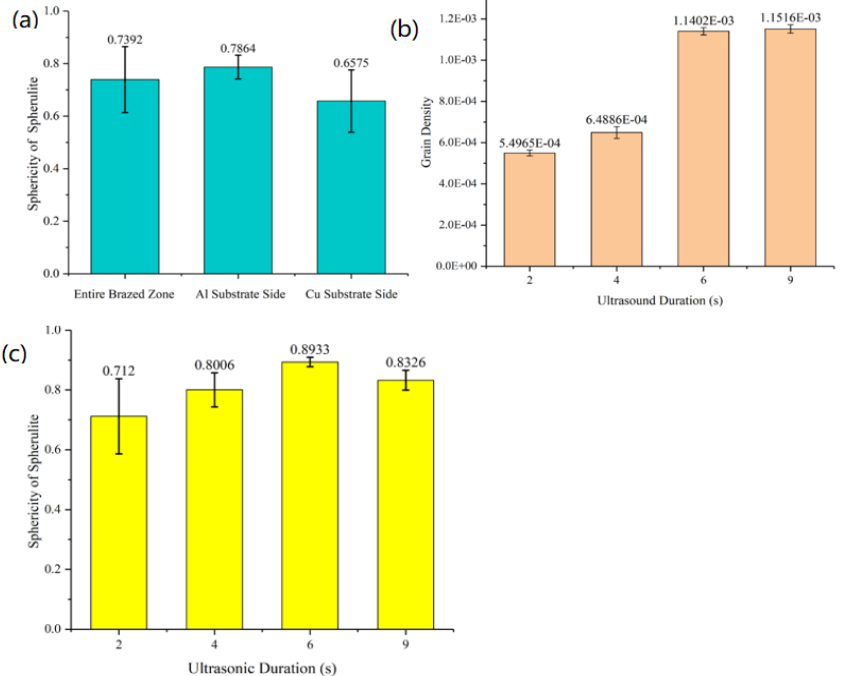
Figure 9. ( a ) spherulite sphericity of each weld seam area when ultrasonic vibration time is 2 s; ( b ) grain density under different ultrasonic duration of 2 s, 4 s, 6 s and 9 s; ( c ) spherulite sphericity under different ultrasonic duration of 2 s, 4 s, 6 s and 9 s.